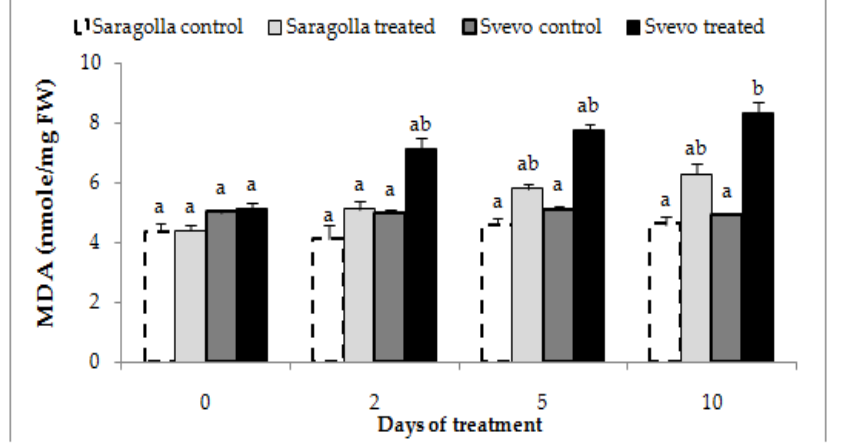
Figure 4. MDA production in roots of Svevo and Saragolla seedlings subjected to osmotic stress. Seven days-old Saragolla and Svevo seedlings were subjected to osmotic stress treatment for 10 days by means of 18% PEG-6000 administration, and after 2, 5 and 10 days, the MDA concentration in roots was measured as reported in Section 4.4, and values compared to those of control, unstressed seedlings. Results from three independent experiments are reported; values are expressed as the mean ± SD. Statistical significance was attributed by one-way ANOVA test. Bars labeled with dissimilar letters are significantly different ( p <